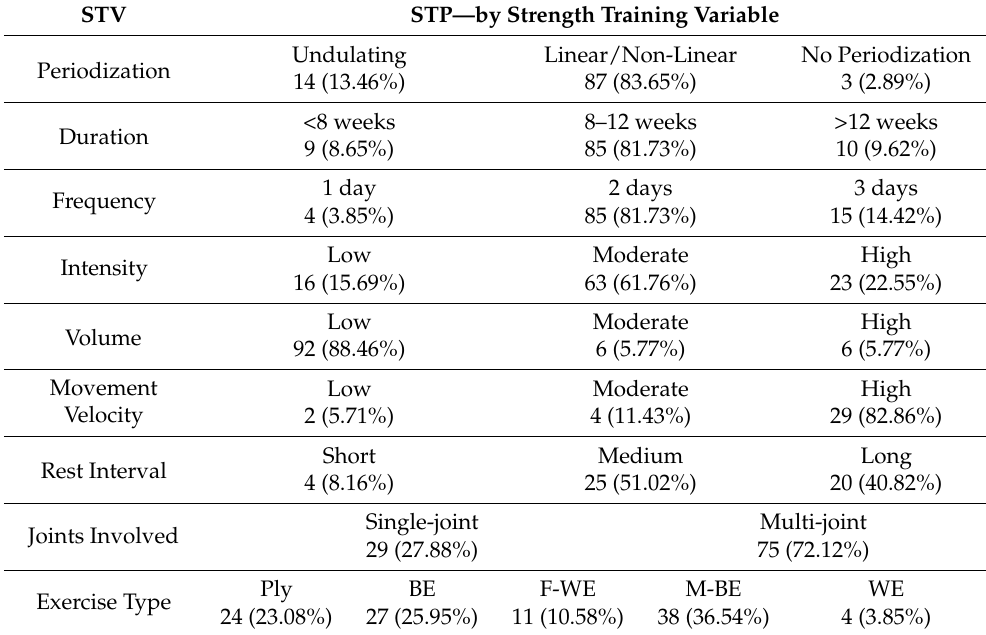
Table 3. Strength training programs (STPs) registered according to the strength training variables (STVs), expressed by absolute ( n ) and relative (%) frequency. STP—by Strength Training